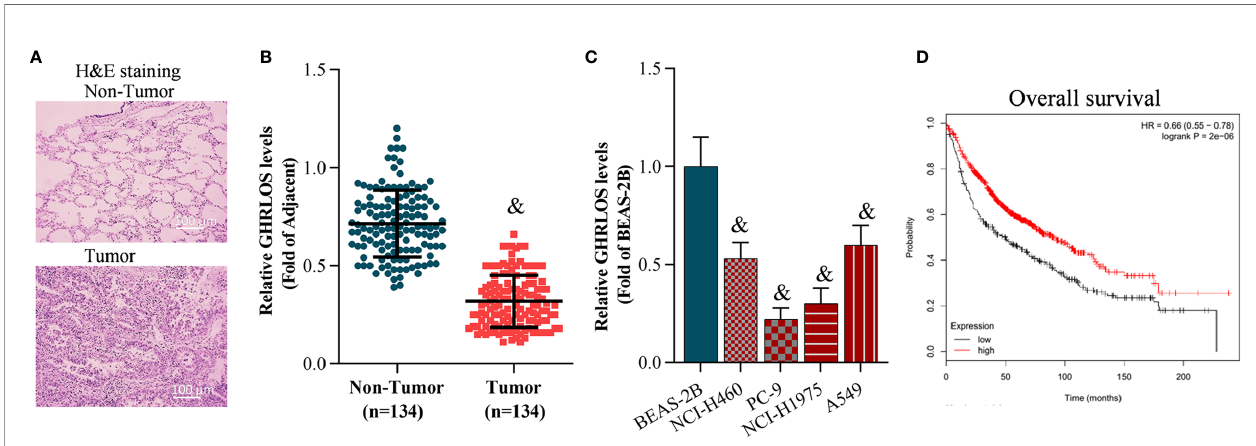
FIGURE 1 | LncRNA GHRLOS expression decreased in lung tumor tissues and is clinically signi fi cant. (A) H&E staining of clinical lung tissue samples, including tumor tissues and non-tumor tissues (adjacent tissues). (B) qRT-PCR analysis of lncRNA GHRLOS expression in lung tissues, & p < 0.01 vs. non-tumor. (C) qRT- PCR analysis of lncRNA GHRLOS expression in human normal pulmonary epithelial cell line (BEAS-2B) and NSCLC cell lines, & p < 0.01 vs. BEAS-2B. (D) Kaplan – Meier analysis of overall survival in NSCLC patients based on lncRNA GHRLOS